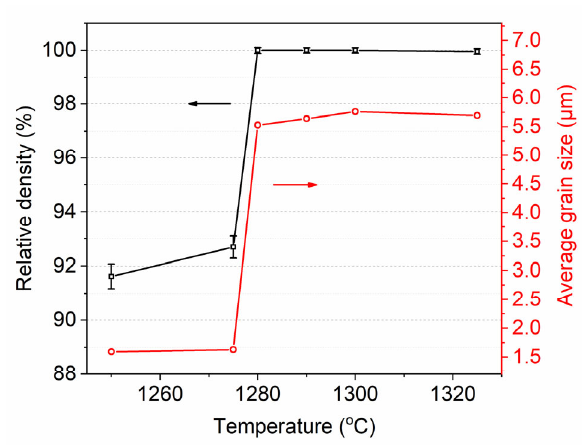
Fig. 8 Relative densities and average grain sizes of the 8YSZ ceramics after HIP post-treatment at 1450 ℃ for 3 h as functions of air pre-sintering temperature.